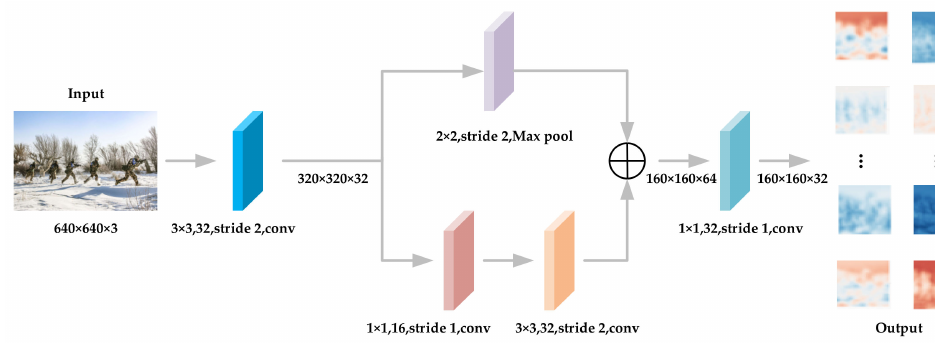
Figure 5. The structure of Stem block.